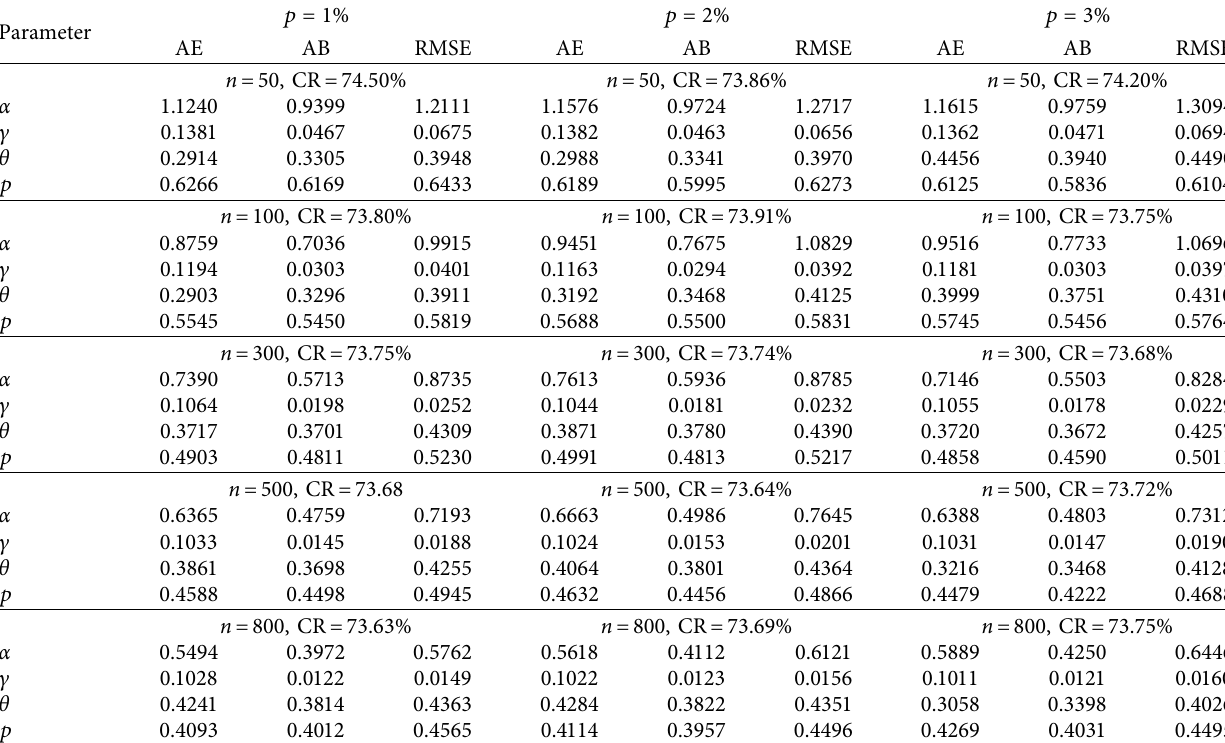
Table 4: Simulation results of SWGII distribution for parameter values ( α , c , θ ) � ( 0 . 2 , 0 . 1 , 0 . 2 )